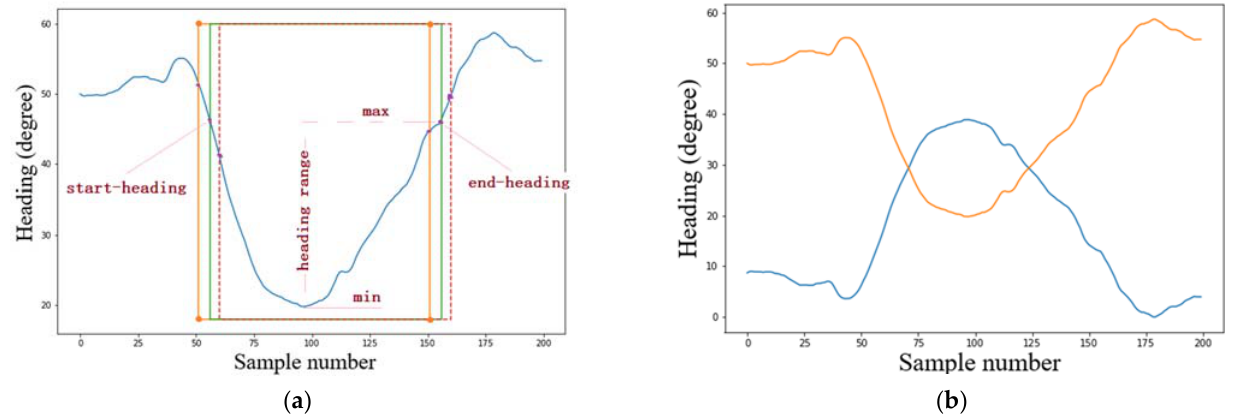
Figure 8. ( a ) Showing the segmentation of the heading sequence using a fixed size window. The orange dotted rectangle is the heading window in which the first heading is about 8 degrees more than the last heading. The red dashed rectangle is the heading window in which the last heading is about 8 degrees more than the first heading. The green valid rectangle is the heading window in which the first heading equals to the last heading. ( b ) The reverse of the heading sequence from left to right to create additional training data.